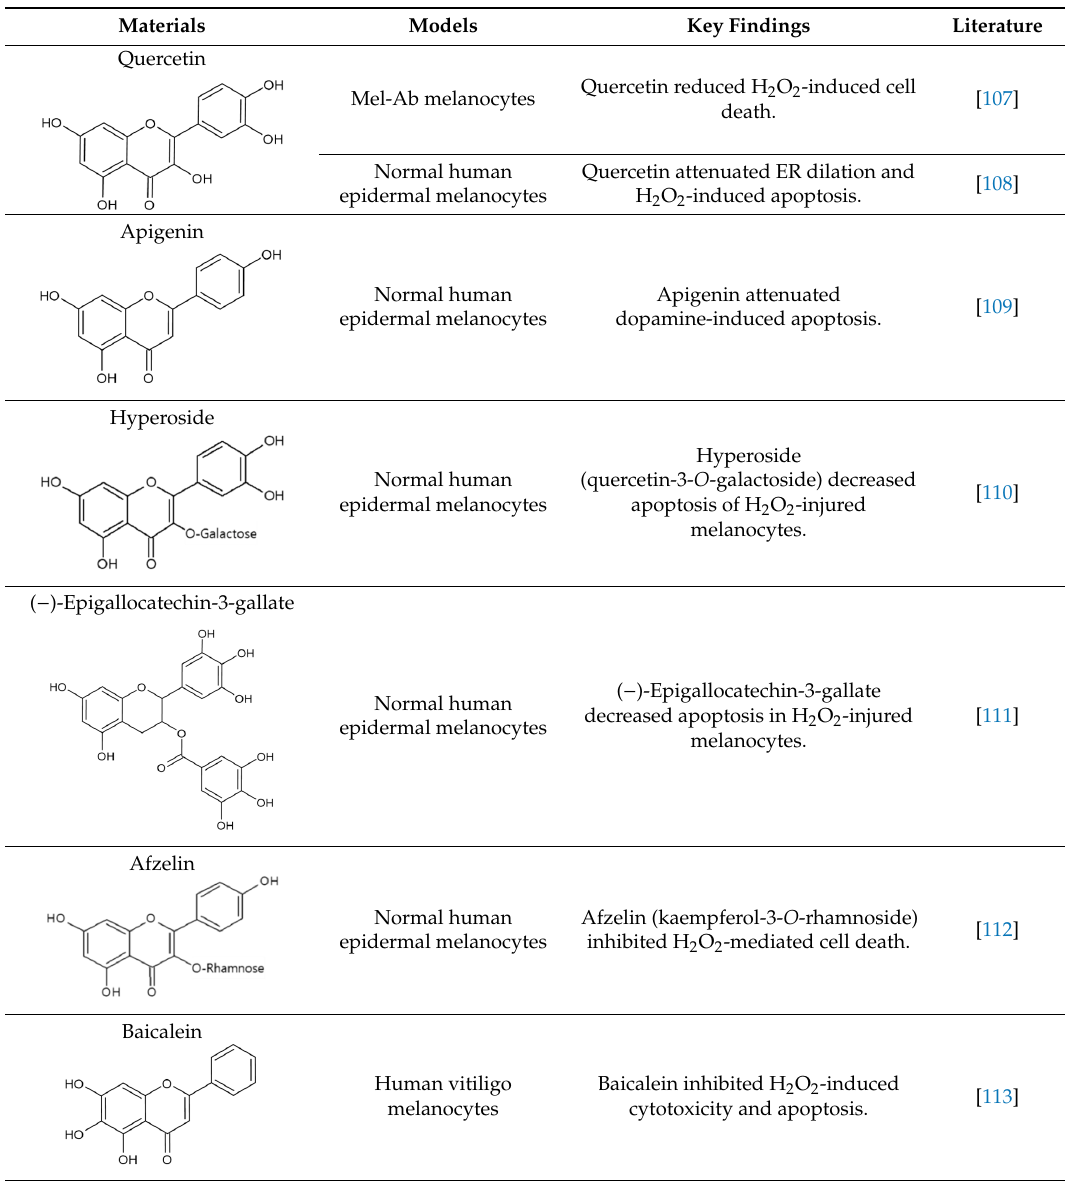
Table 2. Cytoprotective e ff ects of plant-derived antioxidants in melanocytes.